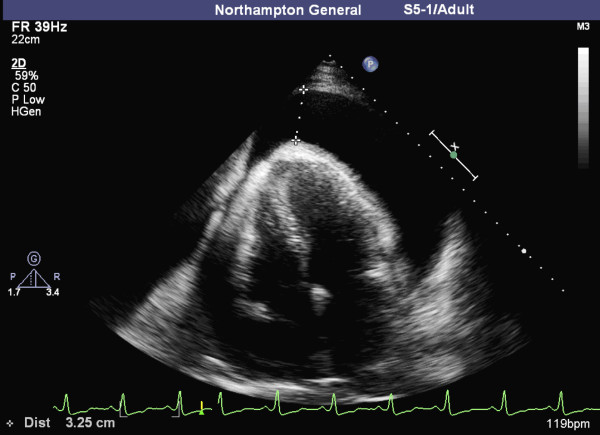
Apical four-chamber ECHO demonstrating: a 3.5 cm pericardial effusion apically (at the cursor) and more than 4 cm around the anterior wall; right atrial collapse from resulting tamponade and; although there was no evidence of left ventricular hypertrophy, the highly echogenic myocardium is also typical of Fabry's.